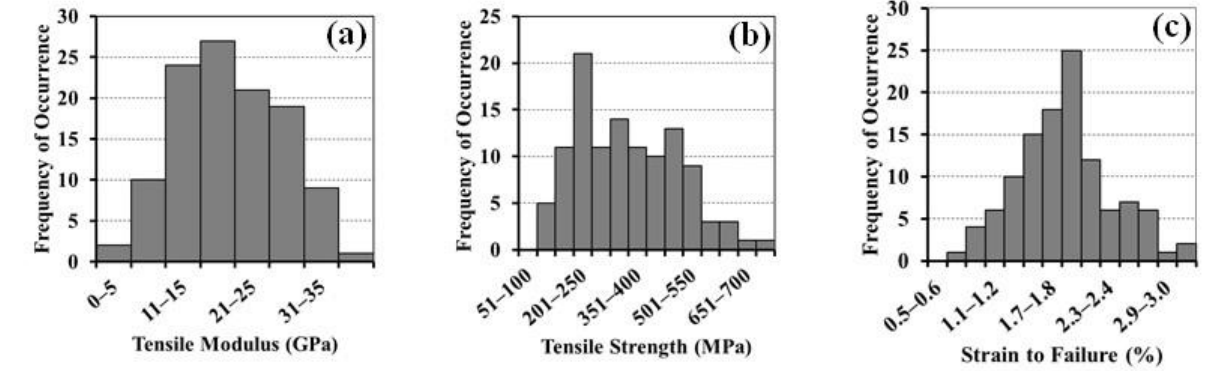
Figure 8. Histograms of measured tensile properties of flax technical fibres: ( a ) modulus, ( b ) strength and ( c ) strain to failure. Table 3. Measured and true tensile properties of flax technical fibres.